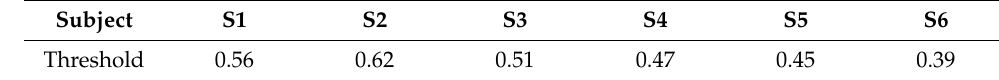
Figure 5. The SSVEP response scores of S5 for selecting correctly for 10 trials. Multi ‐ colored lines represent different stimuli frequencies. The minimum response score of 10 trials is 0.4541, which is set as the threshold for Subject 5. Table 1. SSVEP response threshold of 6 subjects.